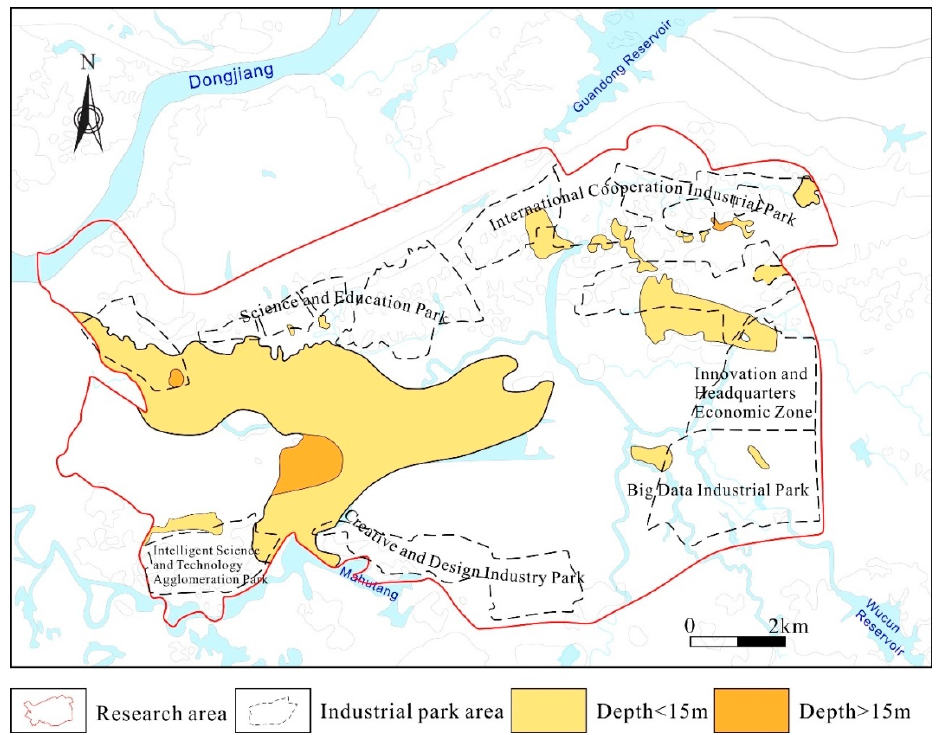
Figure 6. Diagram of the distribution of the soft soil in the study area .